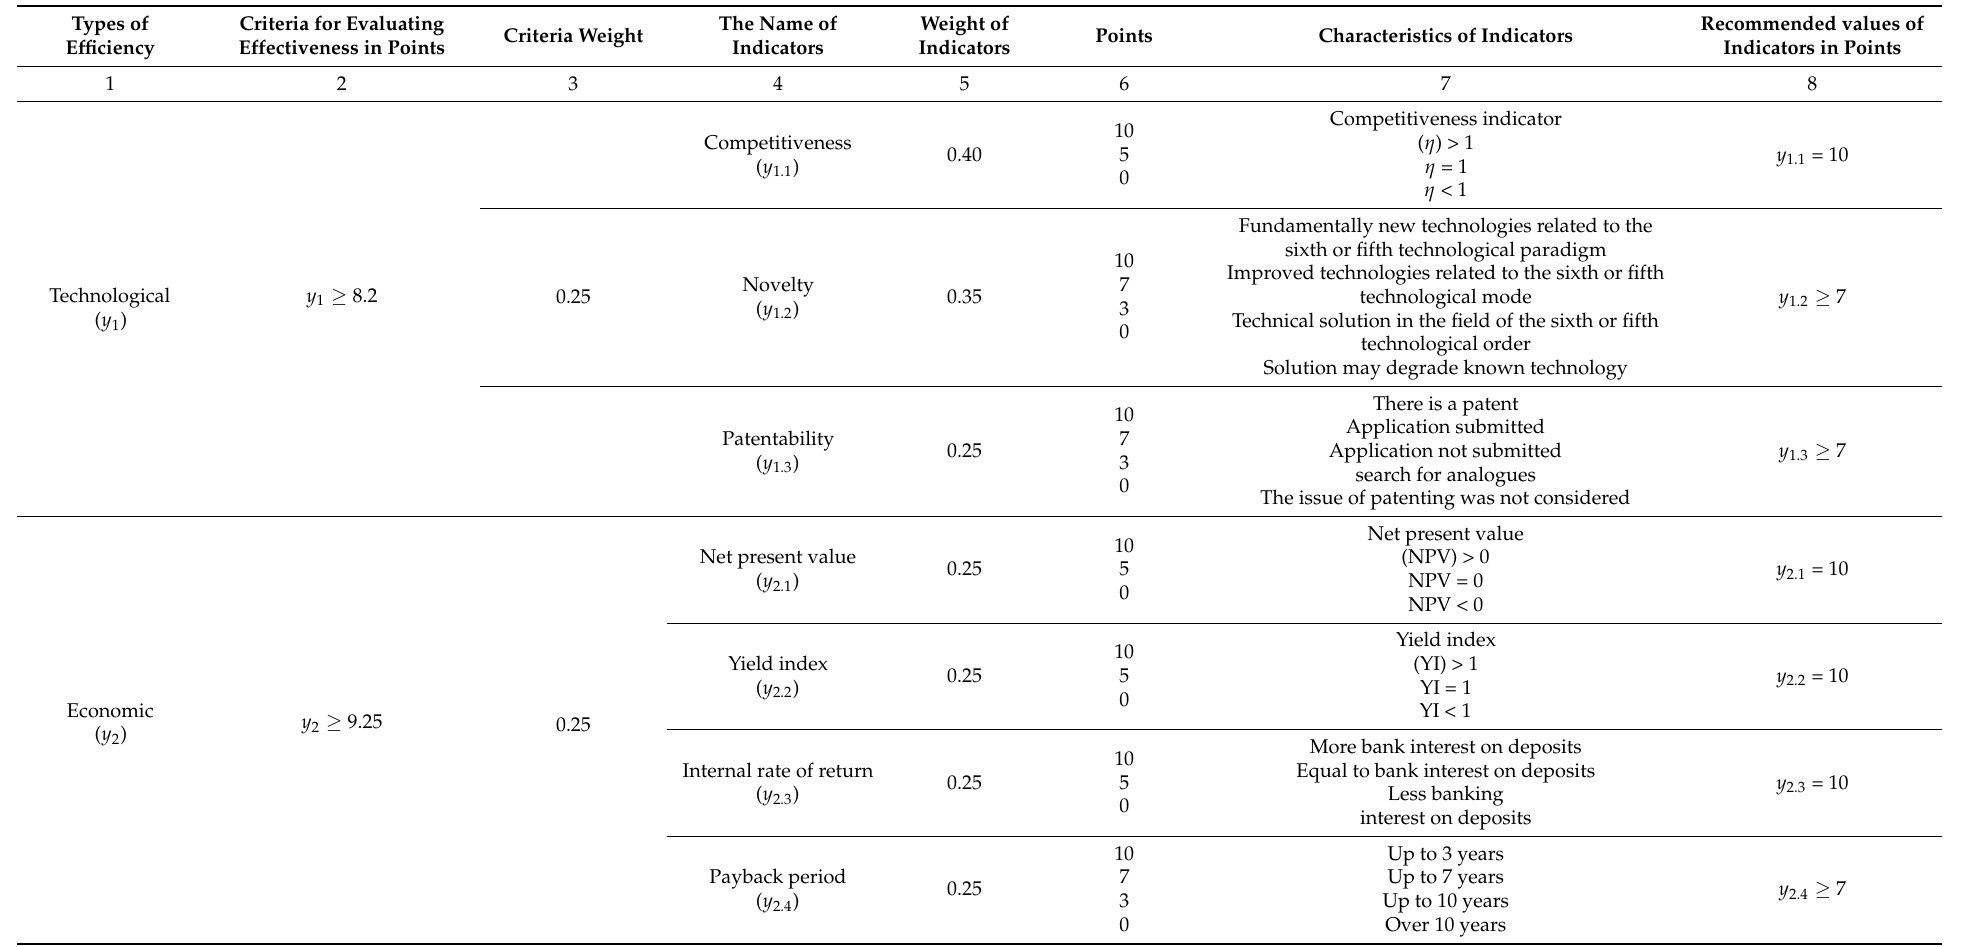
Table 9. Quantitative values of criteria and indicators of the effectiveness of programs for the development of infrastructure for the oil